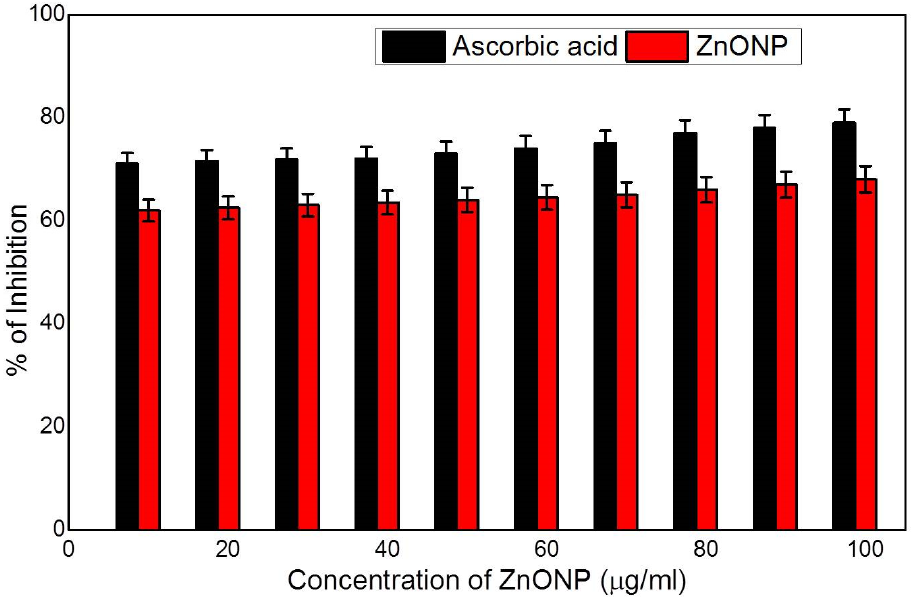
Figure 10. Antioxidant activity of ZnONP.